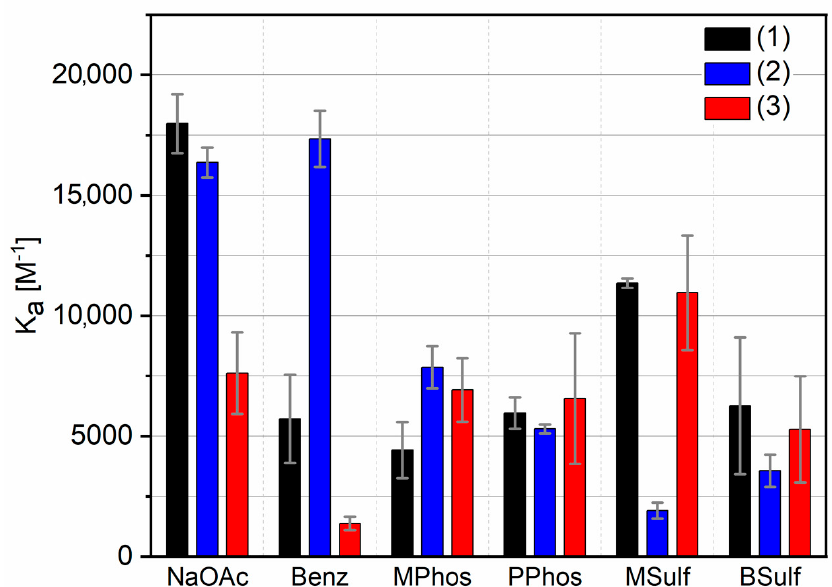
Figure 8. Binding constants of ( 1 ), ( 2 ) and ( 3 ) with different substrates with standard deviations, measured by UV/Vis-Titration. NaOAc: sodium acetate, Benz: benzoic acid, MPhos: methylphosphonic acid, PPhos: phenylphosphonic acid, MSulf: methanesulfonic acid, BSulf: benzenesulfonic acid. Measurements were conducted in bis-tris buffer 6 mM at pH = 6.